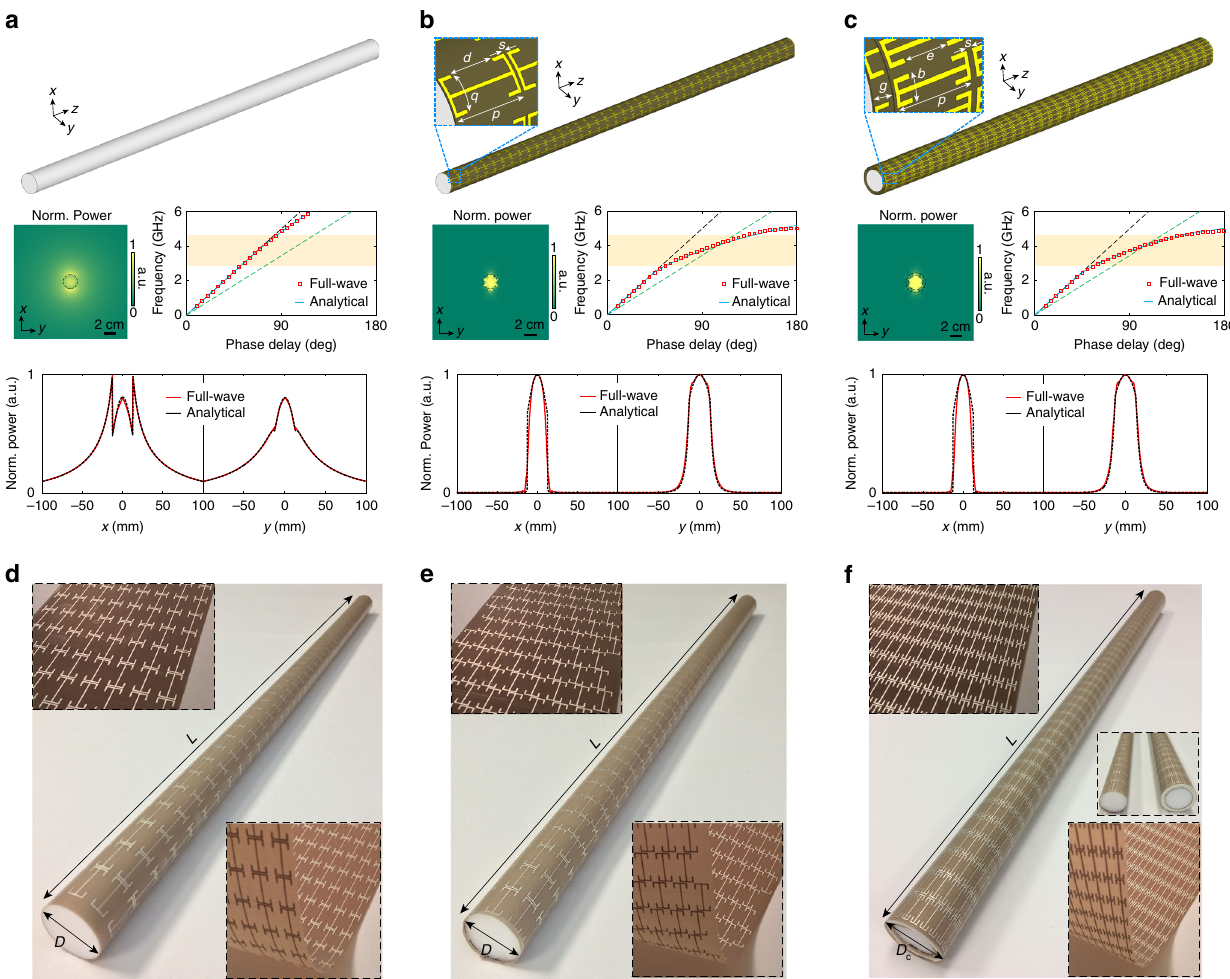
Fig. 1 A sub-wavelength dielectric rod waveguide coated by conformal metasurface layers. Con fi guration, dispersion curves, normalized power distribution in the x - y plane at 3.4 GHz, and normalized power cuts along the x - and y -axis at 3.4 GHz of a a bare Te fl on rod waveguide with ε r = 2.1, b the same Te fl on rod waveguide coated by the metasurface guiding layer, and c the same Te fl on rod waveguide coated by the metasurface guiding and cloaking layers. For the dispersion curves, the dashed gray and dashed green lines are the light lines of free space and Te fl on, respectively. The highlighted region is from 2.8 to 4.59 GHz. The photographs of the fabricated and assembled samples are shown in d for the Te fl on rod coated by the metasurface guiding layer, e for the Te fl on rod coated by the metasurface guiding layer with twisting perturbation, and f for the Te fl on rod coated by the metasurface guiding and cloaking layers. The insets of d – f show enlarged views of the ultrathin fl exible metasurfaces. The dimensions are: b = 3.9, d = 8.5, D = 25.4, D c = 33.4, e = 8.5, g = 4, L = 600, p = 15, s = 0.5, all in millimeters. The substrate material is Taconic TLY-5 ( ε r = 2.2, tan δ = 0.0009) with a thickness of 0.1